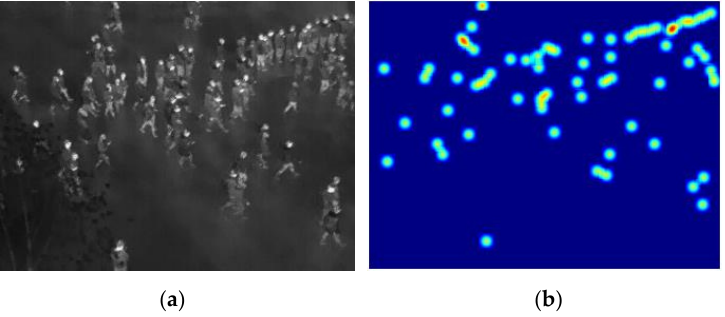
Figure 5. Density map obtained by geometric adaptation of Gaussian kernel. ( a ) Input image; ( b ) corresponding density map.